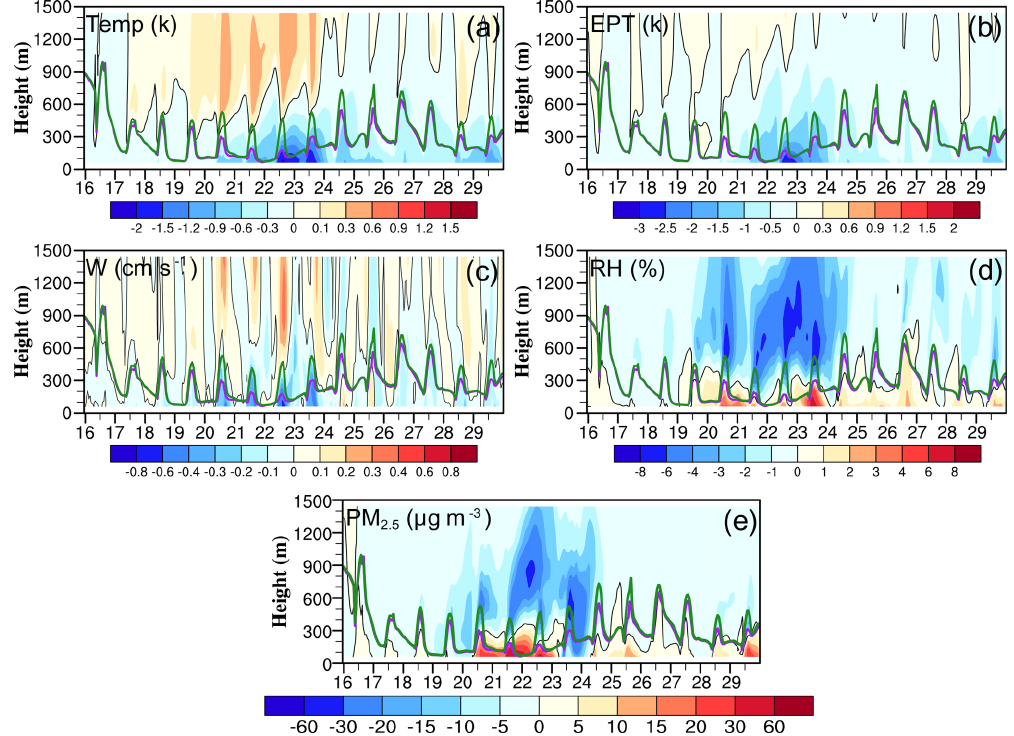
Figure 10. Time series of differences in (a) temperature (K), (b) equivalent potential temperature (K), (c) vertical wind speed (cms − 1 ), (d) relative humidity (%), and (e) PM 2 . 5 concentration (µgm − 3 ) between the CTL and NoARE cases (CTL minus NoARE) averaged over the Beijing–Tianjin–Hebei region. The purple and green lines denote the simulated PBLH in the CTL and NoARE cases, respectively. The black line represents the zero contour